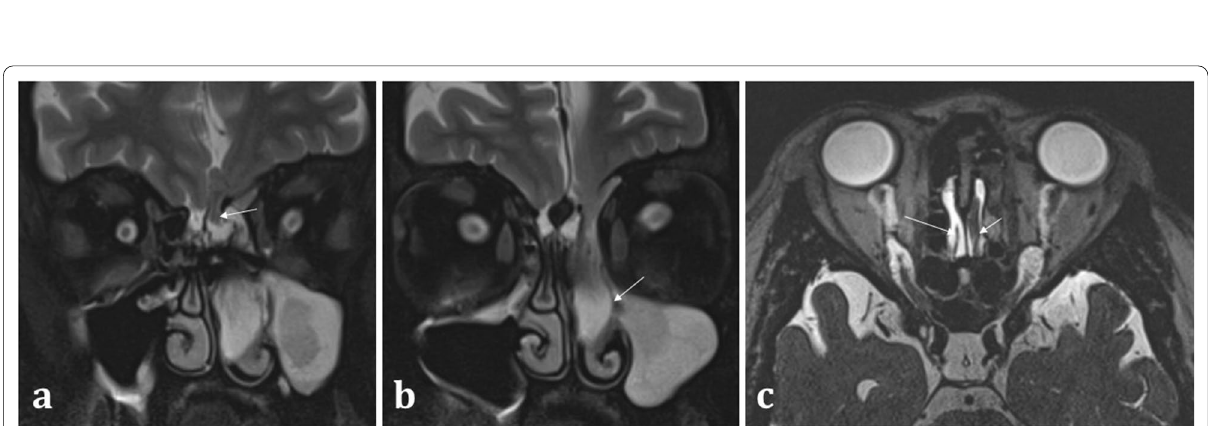
Fig. 16 Acquired non-traumatic CSF fistula secondary to idiopathic intracranial hypertension (IIH). 43-year-old female patient diagnosed with IIH at the age of 16 but lost to follow up, presenting with nasal congestion, CSF rhinorrhoea, and blurred vision. Sequential coronal T2W sequences ( a , b ) demonstrate a large left meningoencephalocoele herniating through the left olfactory recess (arrow, a ), extending down into the nasal cavity and obstructing the left osteomeatal complex (arrow, b ). Heavily T2 weighted CISS sequence ( c ) demonstrates the normal olfactory tract surrounded by CSF on the right (long arrow), and the abnormal herniating brain tissue on the left (short arrow). An “empty sella” with tortuous optic nerves and dilated subarachnoid spaces around the optic nerves are consistent with IIH, which is a well-described cause of acquired CSF